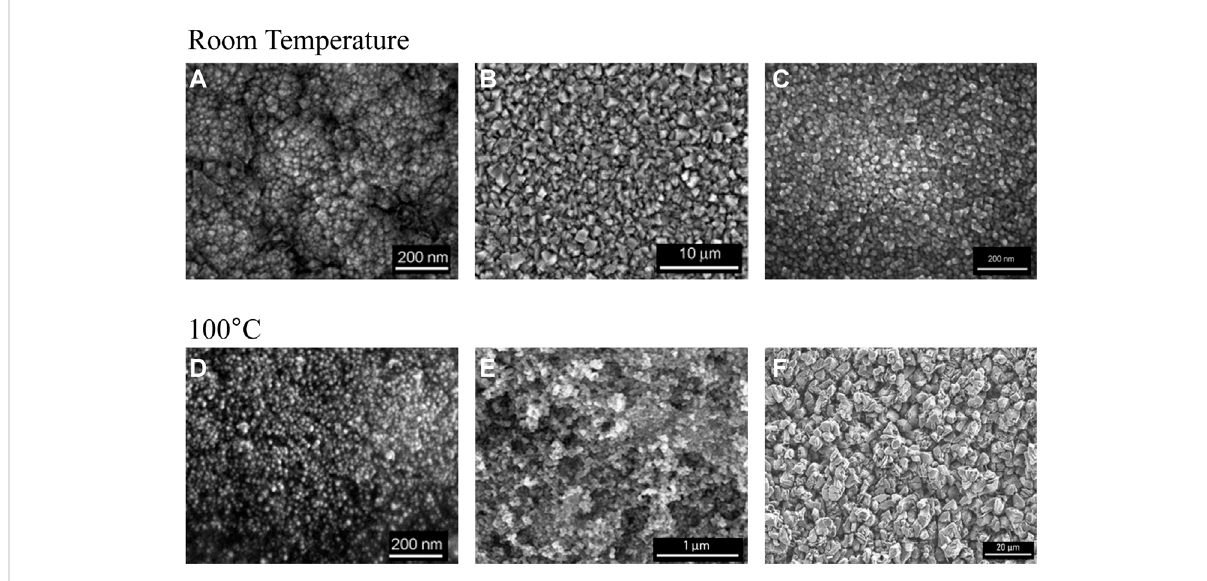
FIGURE 5 SEMimagesofnano(micro)-crystallinealuminumobtainedfromdifferentionicliquids. (A) [BMP][Tf 2 N]Nanoscale. (B) [Emim][Tf 2 N])Microscale. (C) [P 14,6,6,6 ] [Tf 2 N] Nanoscale. (D) [BMP][Tf 2 N] Nanoscale. (E) [Py 1,4 ][TfO] Nanoscale. (F) [Emim][TfO]